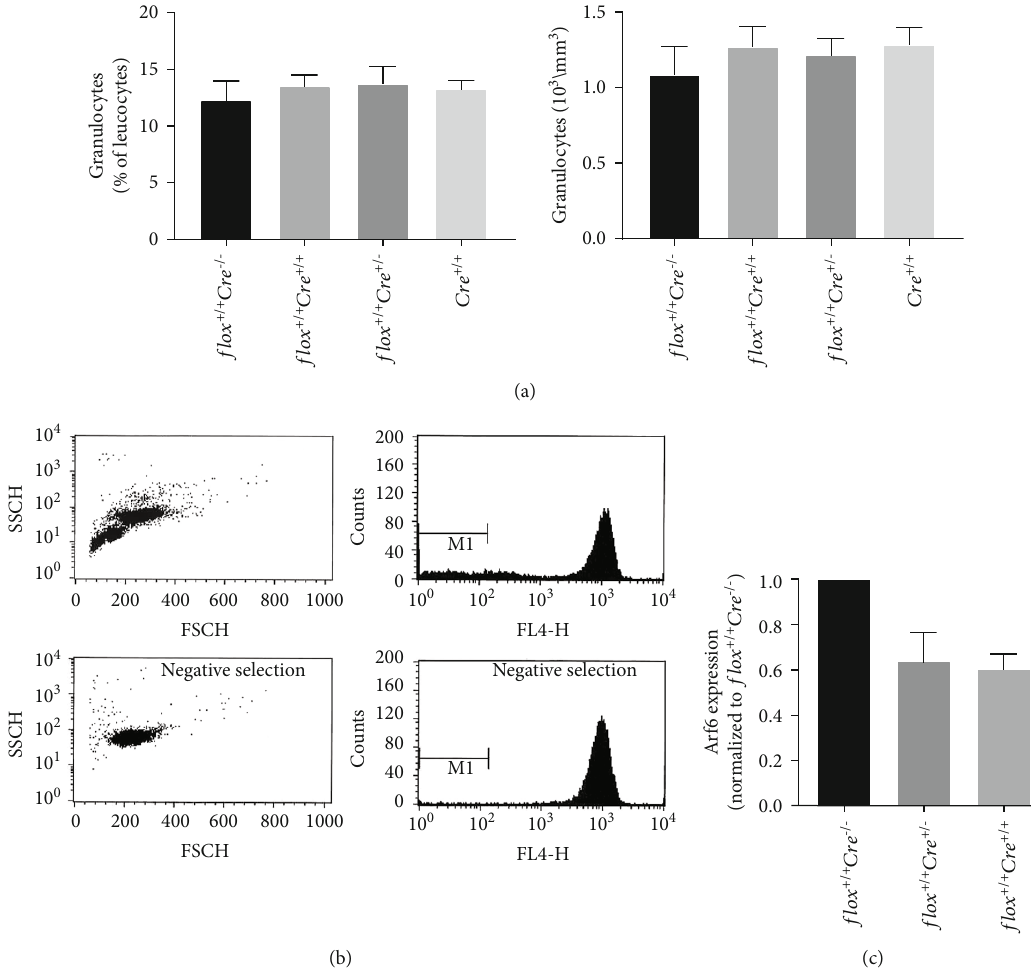
Figure 3: Characterization of PMN-Arf6 cKO mice and of BM-derived PMNs. (a) Peripheral blood granulocyte counts in PMN-Arf6 cKO mice bearing one ( fl ox +/+ Cre +/- ) or two Cre alleles ( fl ox +/+ Cre +/+ ), in control Arf6- fl oxed ( fl ox +/+ Cre -/- ) and control homozygous Elane-Cre ( fl ox -/- Cre +/+ ) mice ( n = 5 mice). Left (% of total leukocytes) and right (absolute number by mm 3 ). (b) BM PMNs were puri fi ed from BMs using only Percoll gradient separation (upper panels) and negative enrichment (lower panels) as described in Materials and Methods. (c) Semiquantitative RT-PCR analysis of Arf6 mRNA levels in PMNs puri fi ed from BMs ( n = 3 -5 independent